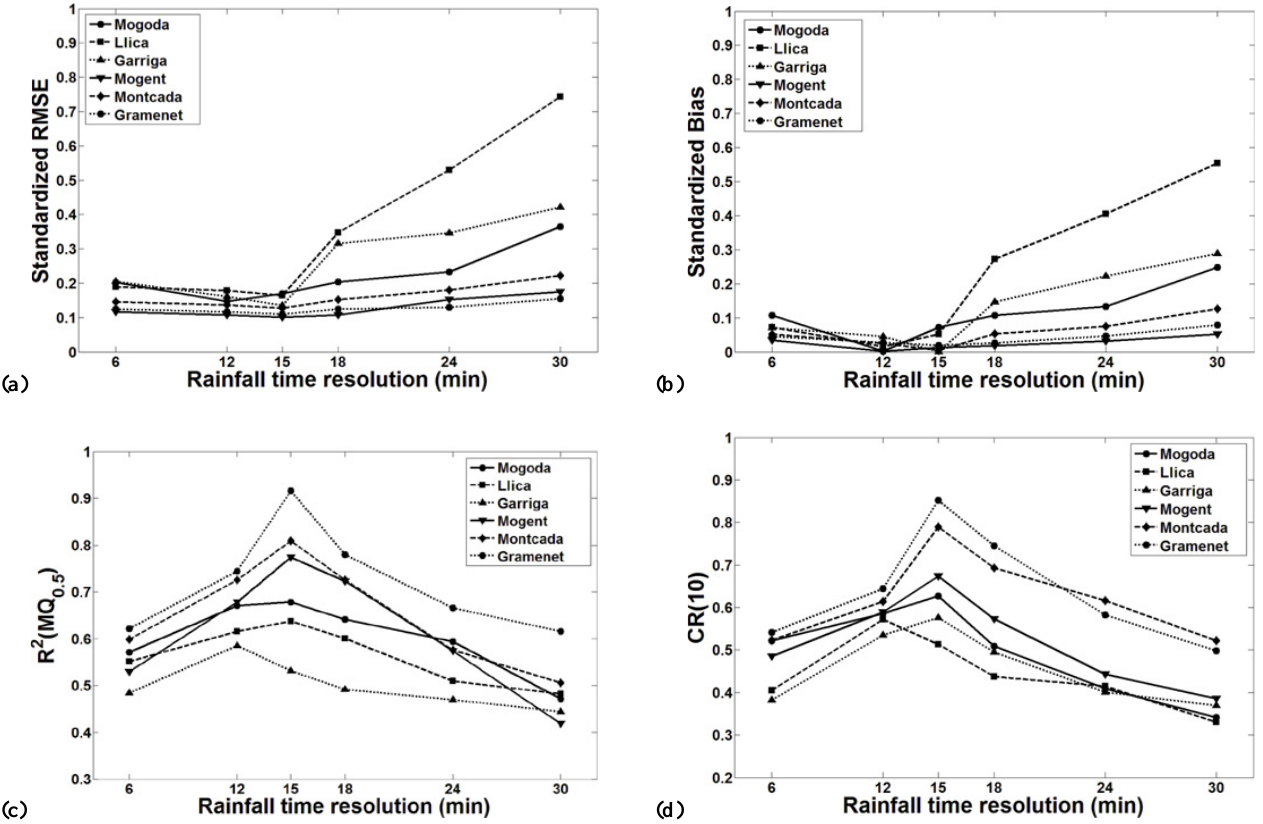
Fig. 14. Validation measures plotted versus rainfall time resolution for all stations. (a) Root Mean Square Error (RMSE), standardized by observed peak discharge (b) ; absolute value of Bias (ME), standardized by observed peak discharge. (c) ash-Sutcliffe global efficiency index R 2 ( MQ 0 . 5 ) . (d) Containing Ratio for a confidence level of 10% [ CR ( 10% ) ] . Table 5. Summary of calibration results for each parameter for all time resolutions. Table shows mean value ( µ ) and standard deviation ( σ ) of the parameter distribution.